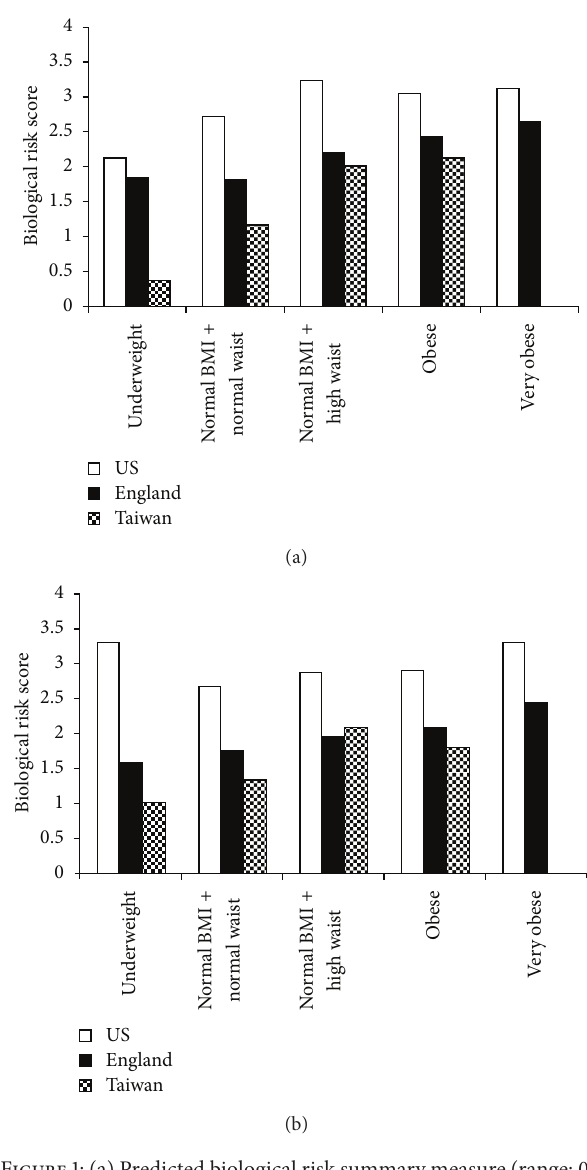
Figure 1: (a) Predicted biological risk summary measure (range: 0– 8) in the US, England, and Taiwan by weight categories for men aged 65 who are nonsmokers, do not engage in physical activity, and are currently taking antihypertensive medication. (b) Predicted biological risk summary measure (range: 0–8) in the US, England, and Taiwan by weight categories for women aged 65 who are nonsmokers, do not engage in physical activity, and are currently taking antihypertensive